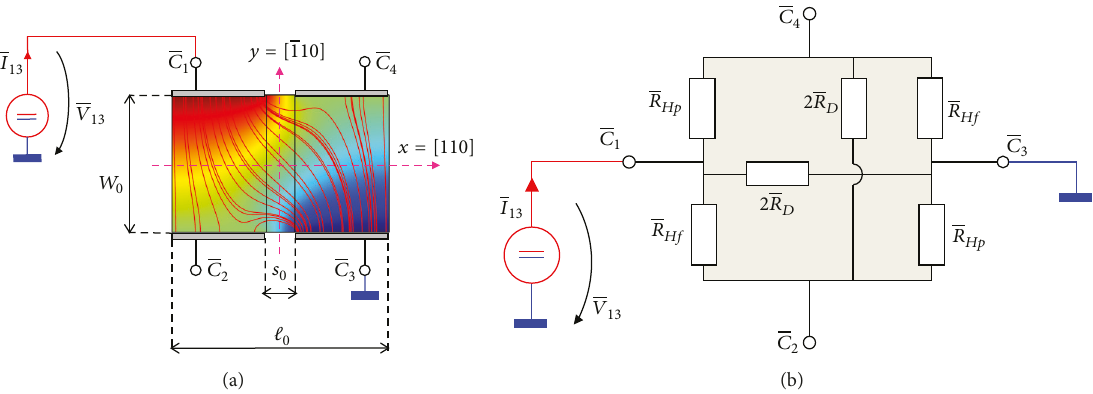
Figure 6: Rectangular 𝜎 𝑥𝑥 − 𝜎 𝑦𝑦 stress sensor in (100)-silicon with two perpendicular mirror-symmetry axes 𝑥 = [110] , 𝑦 = [110] . No magnetic field is applied. An input voltage is forced between contacts 𝐶 1 – 𝐶 3 and an output voltage is tapped between 𝐶 2 – 𝐶 4 . All contacts have the same size (ℓ 0 − 𝑠 0 )/2 . (a) shows the top view of the potential distribution and the current streamlines in the plane device. (b) shows the equivalent resistor circuit